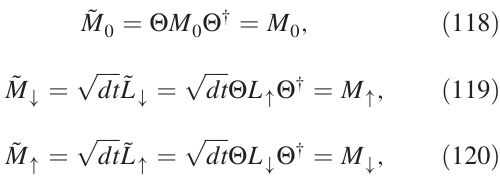
_ X φ ). The cavity mode starts in